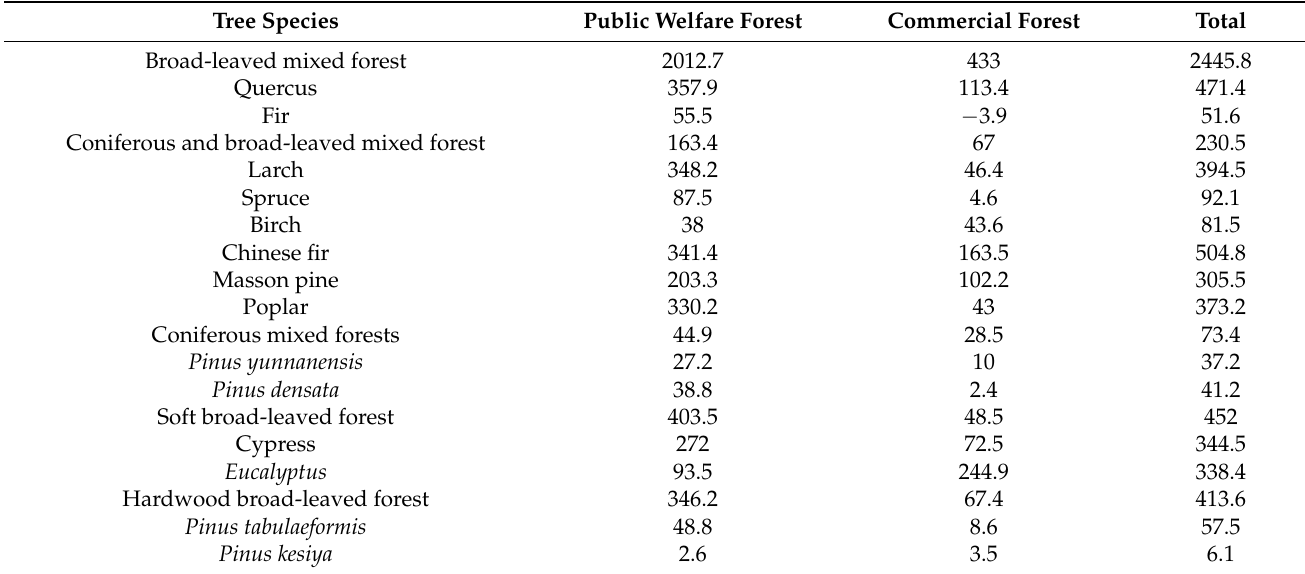
Table 4. The total cumulative carbon sequestered by the 19 dominant tree species during the study period was 6714.7 MtC, of which 5215.6 MtC was fixed by public welfare forests and 1499.1 MtC by commercial forests. The main sources of carbon sinks in public welfare forests were broad-leaved mixed forest, quercus, soft broad-leaved forest, and hardwood broad-leaved forest, while the main sources of carbon sinks in commercial forests were eucalyptus , Chinese fir, and masson pine. Over the study period, the cumulative carbon sinks of broad-leaved mixed forest and eucalyptus were relatively high, up to 2445.8 MtC and 1014.4 MtC, respectively. It should be noted that the cumulative carbon stock from commercial forests of fir was negative. This is because the vegetation carbon stock of fir significantly reduced in the latter years of the simulation due to human harvesting, which was lower than that in the early part of the simulation. Table 4. Cumulative carbon stock by dominant tree species of China’s existing arbor forests from 2019 to 2060